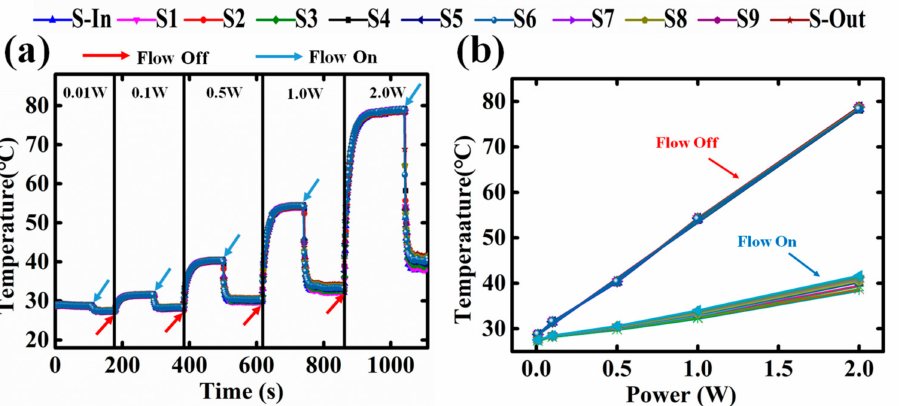
Figure 5. ( a ) Temperature sensors response under different power applied on the heat source (0.01 W, 0.1 W, 0.5 W, 1.0 W, 2.0 W) with the condition of flow off or flow on; ( b ) The temperature profile in the micro-fluid channel from the inlet to outlet under different heating power.